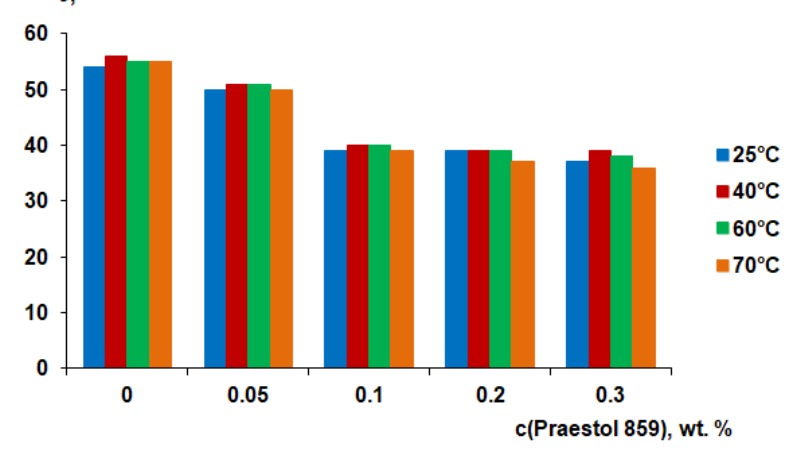
Figure 11. Water contact angle of the membrane selective layer of PSF-based membranes vs. Praestol 859 concentration in the coagulation bath at di ff erent